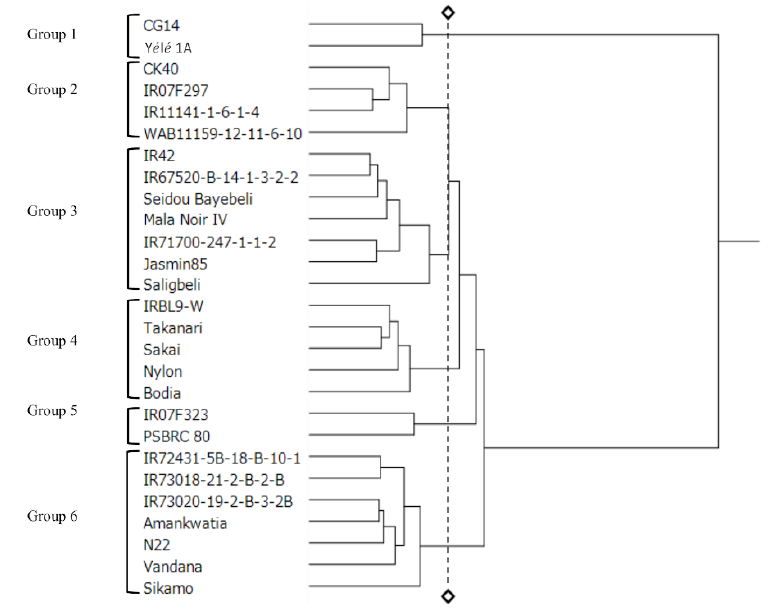
Figure 1. Result of cluster analysis of the 27 rice genotypes based on time to achieve 50% germination (G50), mean germination time (MGT), time to achieve 50% plant emergence (E50), mean plant emergence time (MET), plant emergence uniformity (EU), plant height (PH) and plant height uniformity (PHU) in 4 soil moisture conditions (5%, 10%, 15% and 20%) by hierarchical cluster analysis.